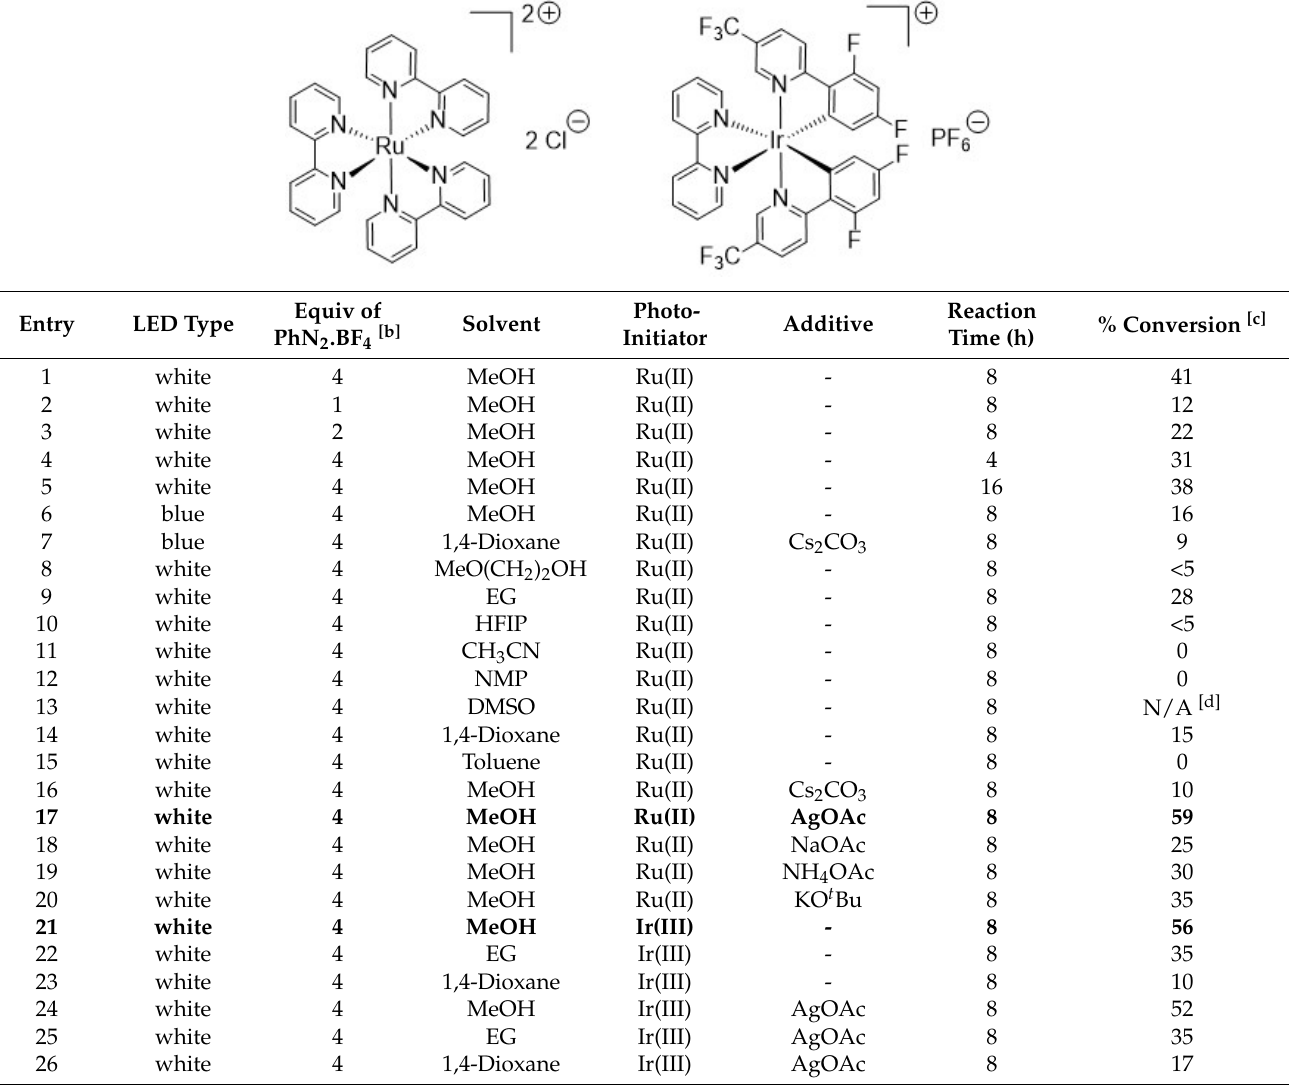
Table 2. Various conditions screened for application in the photoactivated C–H arylation step, based on the reaction of model compound 8a with PhN 2 .BF 4 ( 9 ), under LED light, Pd(OAc) 2 catalysis and Ru(II) or Ir(III) photoinitiation (for reaction, see Scheme 4). [a]